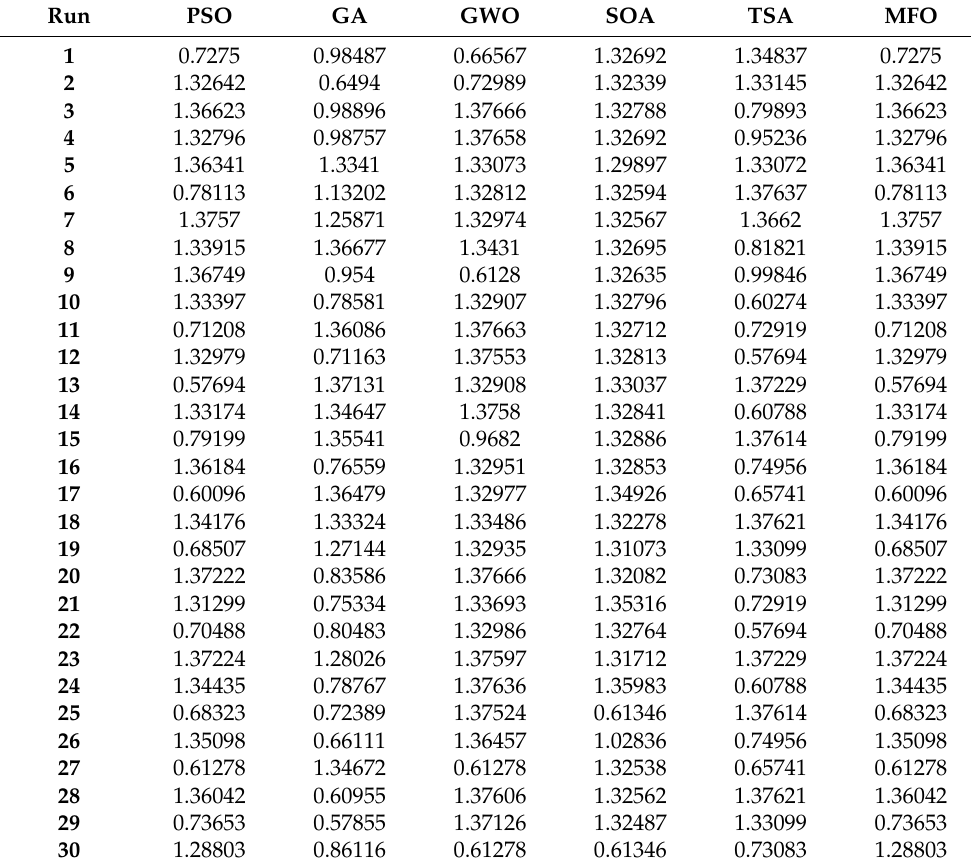
Table 3. ANOVA numeric results.